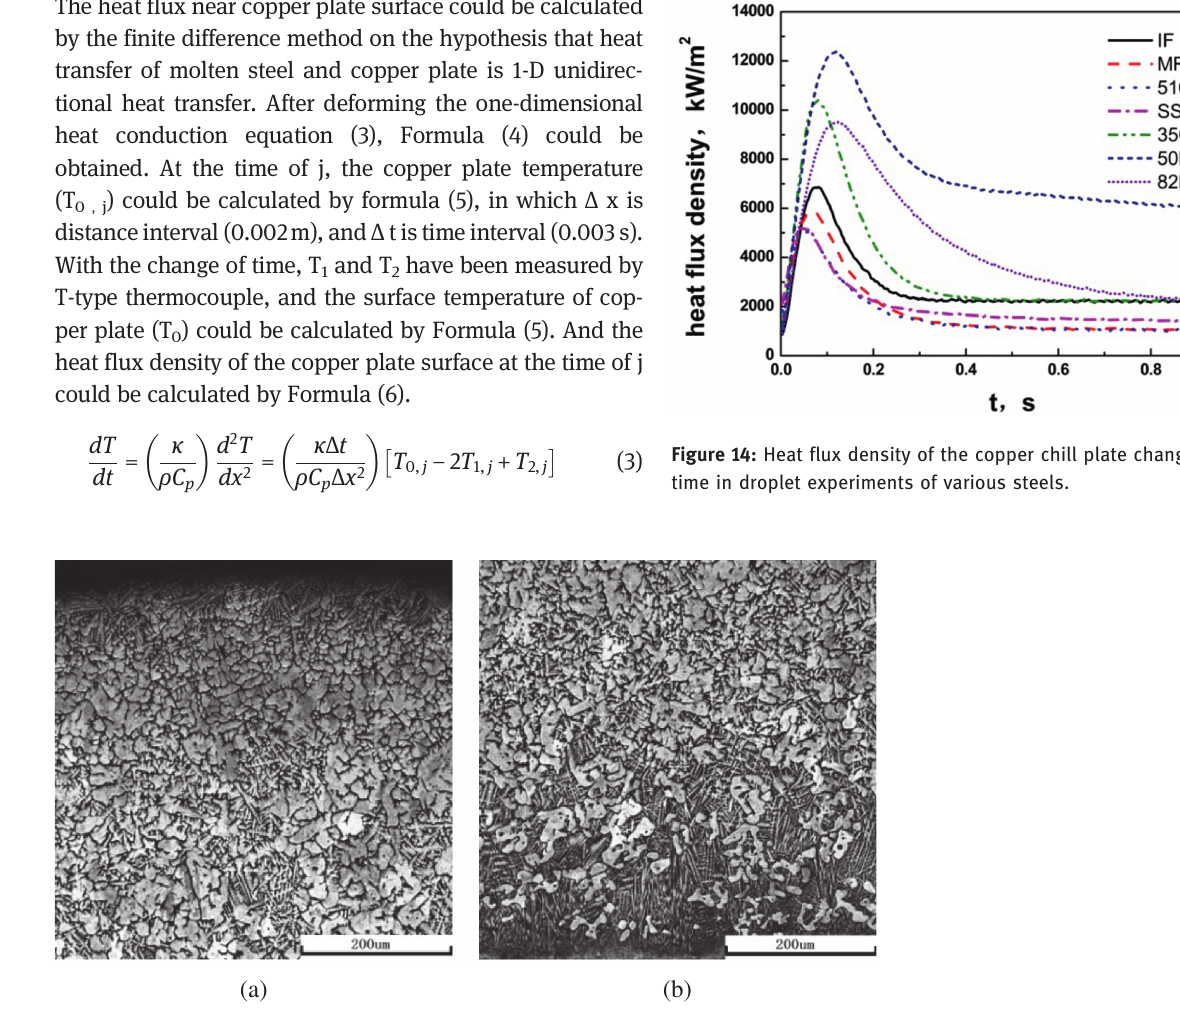
Figure 13: Macrostructures of center section of solidified shell of 50 Mn steel (supersaturated picric acid erosion, 1,000 × ), (a) top center; (b) bottom center.